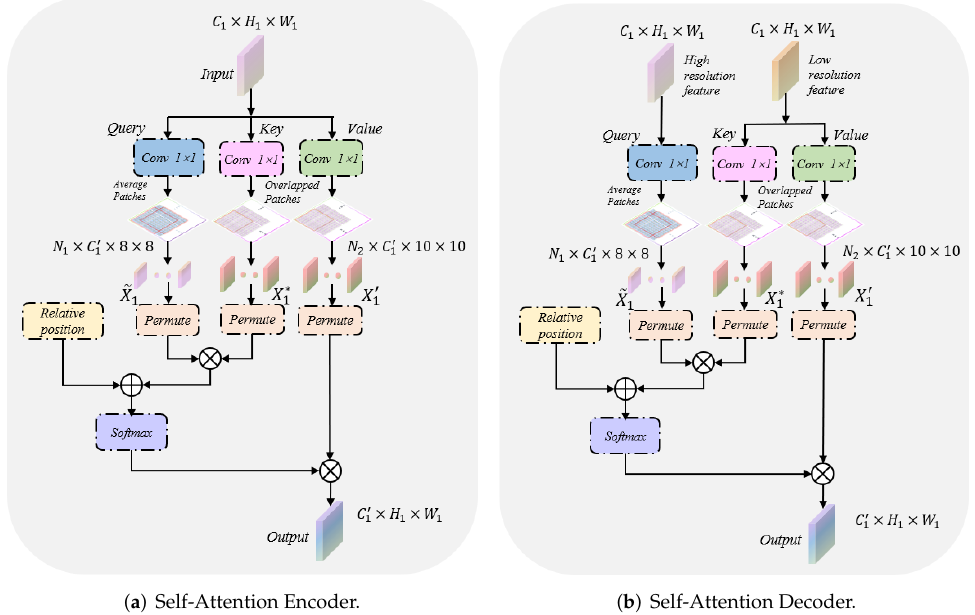
Figure 3. The proposed novel self-attention, where N 1 , N 2 are the patch number, ⊗ is matrix multiplication and ⊕ denotes concatenation operation. ( a , b ) denote the encoder and decoder of self-attention, respectively. They share similar concepts. Significantly, the decoder of the self-attention takes high-resolution features from the encoder for query, and low-resolution features from the decoder for key and